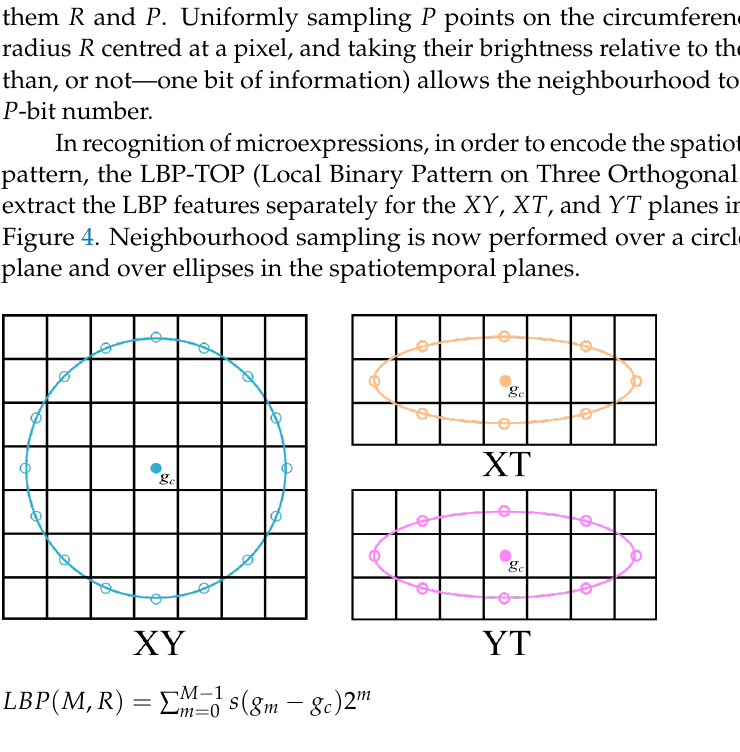
Figure 4. Detailed sampling for LBP-TOP with RX = RY = R = 3, RT = R = 1, PXY = M = 16, and PXT = PYT = M =